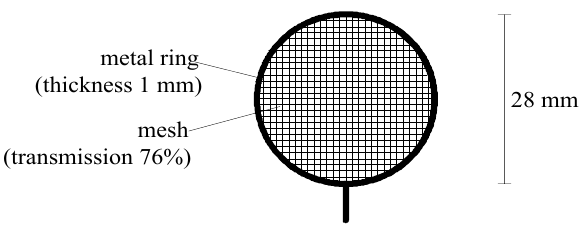
Fig. 1. Geometry of the mesh studied in the wind tunnel.